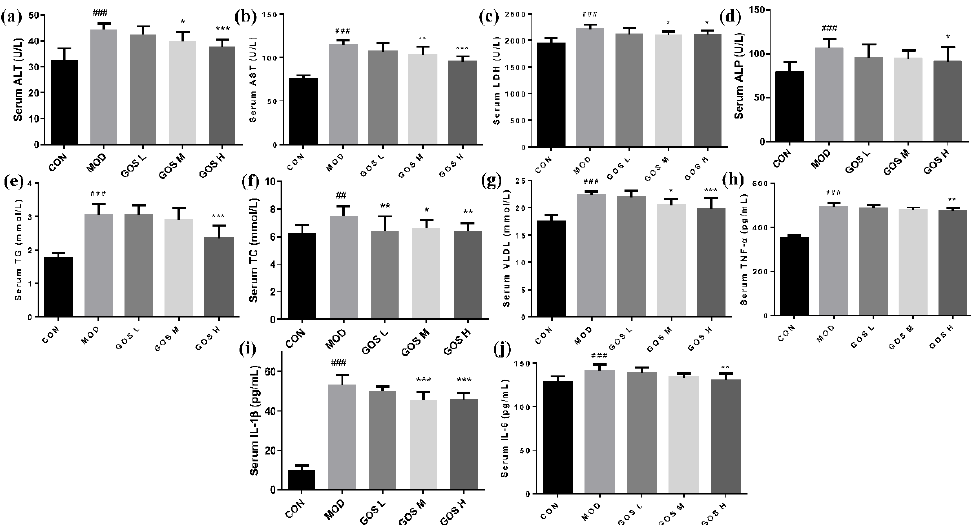
Figure 5. Effects of GOS on serum levels of proteins related to liver function and inflammatory factors in mice ( n = 10, means ± SD). ( a ) Serum ALT. ( b ) Serum AST. ( c ) Serum LDH. ( d ) Serum ALP. ( e ) Serum TG. ( f ) Serum TC. ( g ) Serum VLDL. ( h ) Serum TNF- α. ( i ) Serum IL- 1β. ( j ) Serum IL-6.